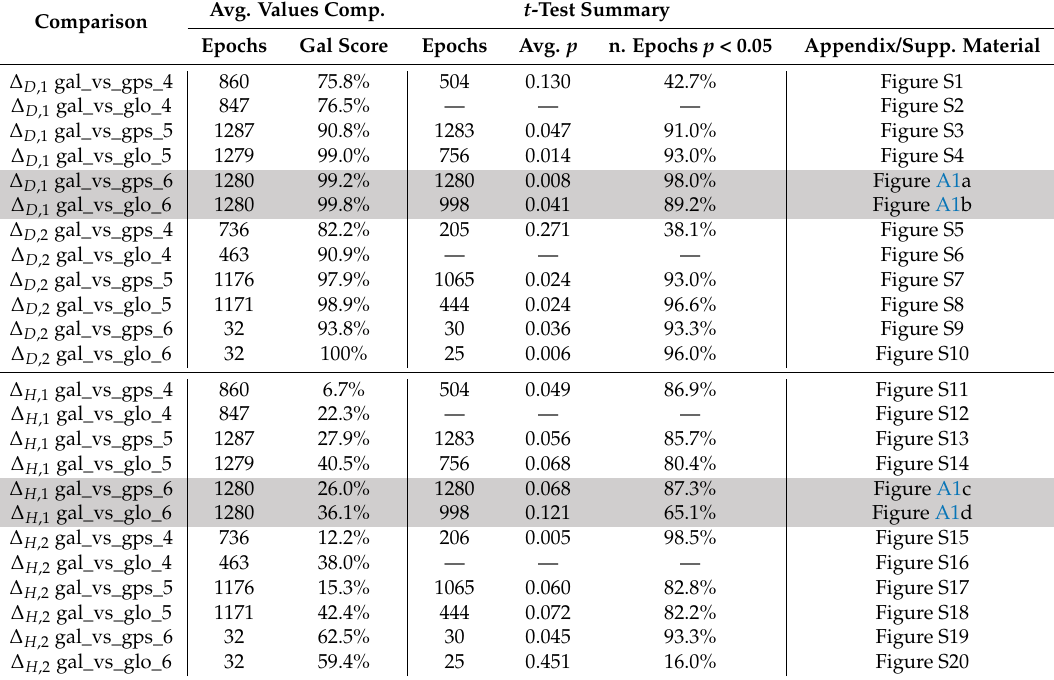
Table 4. Summary of the comparisons. The “comparison” column shows the object of the comparison for fixed ( ∆ D,1 or ∆ H,1 ) or float ( ∆ D,2 or ∆ H,2 ) solutions with n satellites (with n = 4, 5, 6) for the Galileo (gal), GPS (gps), and GLONASS (glo) constellations. The average values comparisons columns (Avg. values comp.) show the number of epochs in which it was possible to execute the simple comparisons between the means and the number of times, expressed in percentage, in which Galileo performed better. The t -test summary columns show the number of epochs with one sample t -test, the average p -value, the number of epochs, expressed in percentage, in which the p -value was less than 0.5. Avg. Values Comp. t -Test Summary Comparison